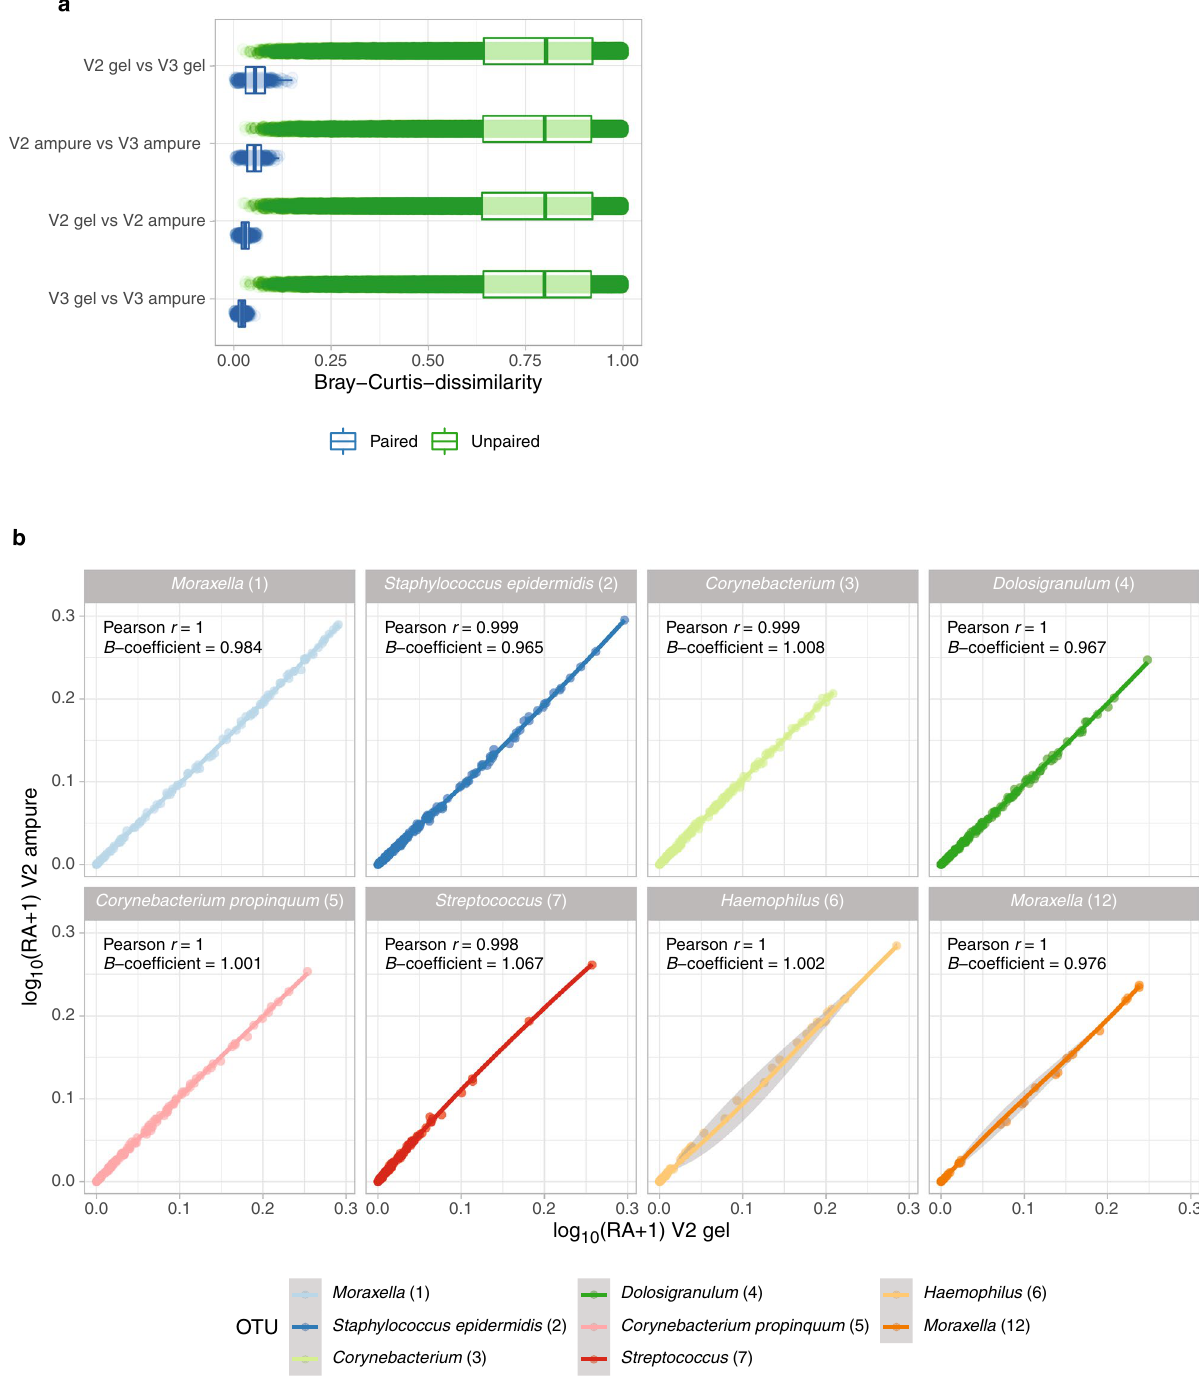
Figure 4. Similarity of a library (n = 214) purified by gel or AMPure XP. ( a ) To quantify differences in the overall microbial community composition between (pairs of) samples, Bray–Curtis dissimilarity was used, where zero indicates an identical composition between pairs. Unpaired dissimilarity was determined by calculating the dissimilarity of a given sample to all other (unpaired) samples in the other group, whereas paired dissimilarity refers to the dissimilarity between pairs of samples in both groups. Boxplot depicts the 25th and 75th percentiles by lower and upper hinges, respectively, the median is depicted by a horizontal line in the box. The measurements that fall within 1.5 times the interquartile range are shown by whiskers. ( b ) Correlation plots visualizes log 10 + 1-transformed relative abundances of the top 8 OTUs of a pool sequenced using the V2 reagent kit, comparing gel-based and AMPure XP purification methods. For each OTU, the Pearson correlation coefficient and regression coefficient (slope) was calculated. Both the correlation coefficient and the slope show a value close to 1.0, indicating a perfect correlation between purification methods for these